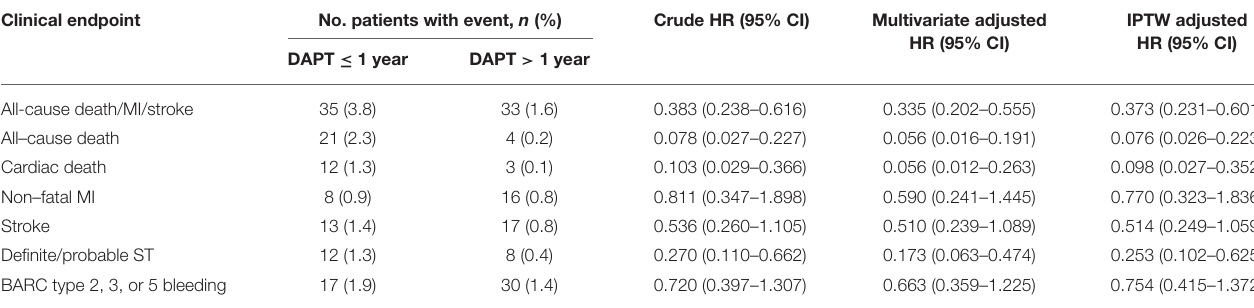
TABLE 2 | Clinical outcomes at 2.4 years according to DAPT time.